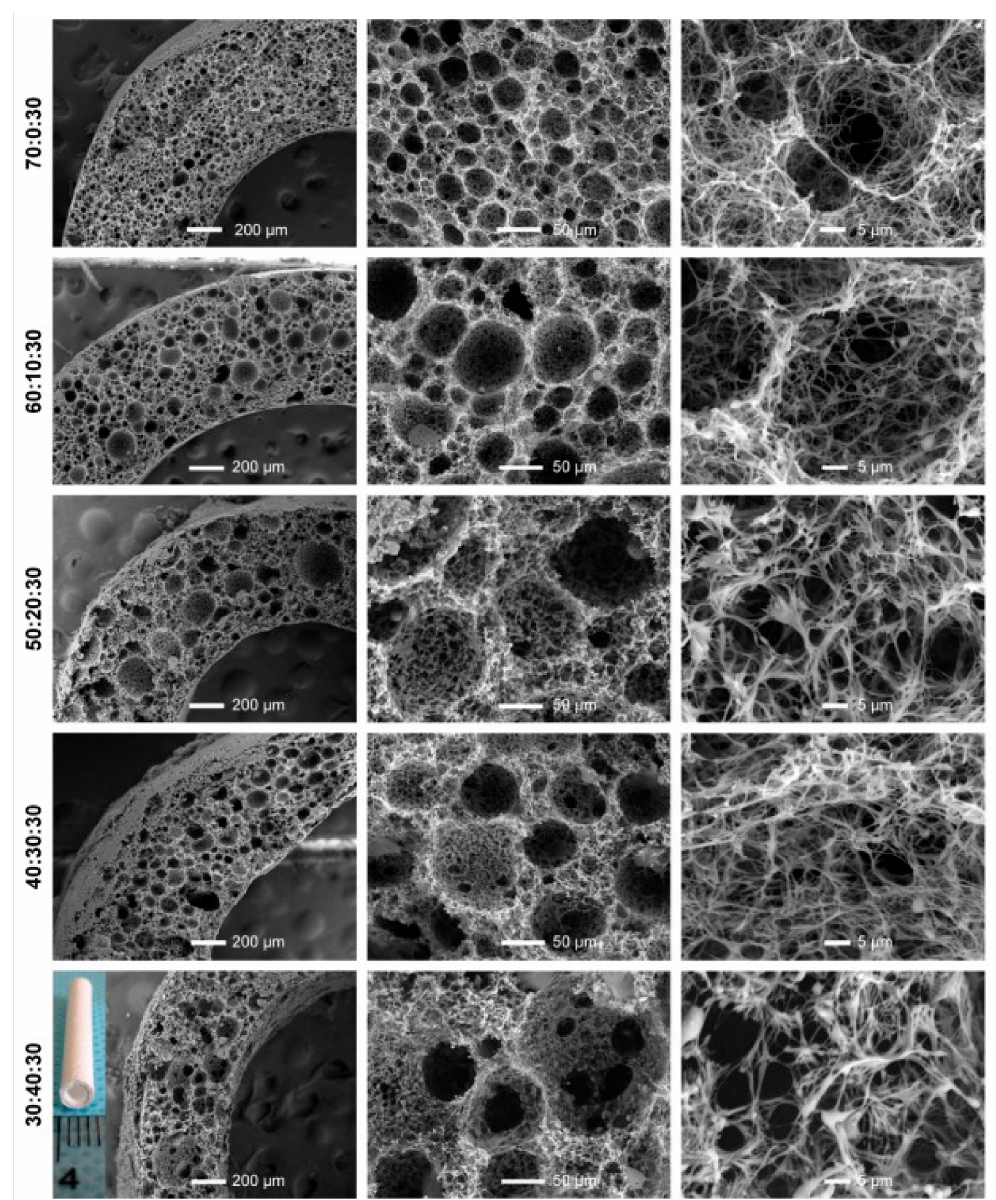
Figure 13. The SEM images and pore diameter distributions of PLLA/PLGA/PCL composite scaf- folds with various weight ratios. Reprinted with permission from Dove Press